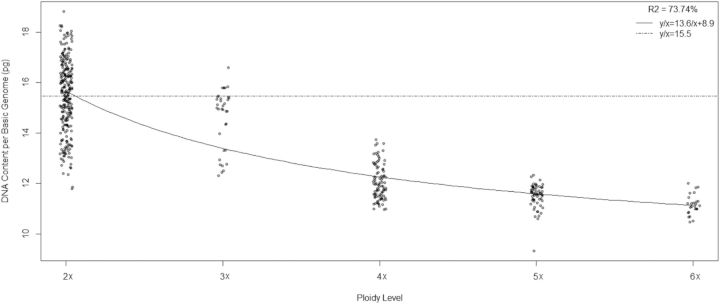
DNA content per basic genome (1Cx) plotted against ploidy level. Solid line, linear fit/ploidy level (x); broken line, extrapolated from diploids/ploidy level (x).